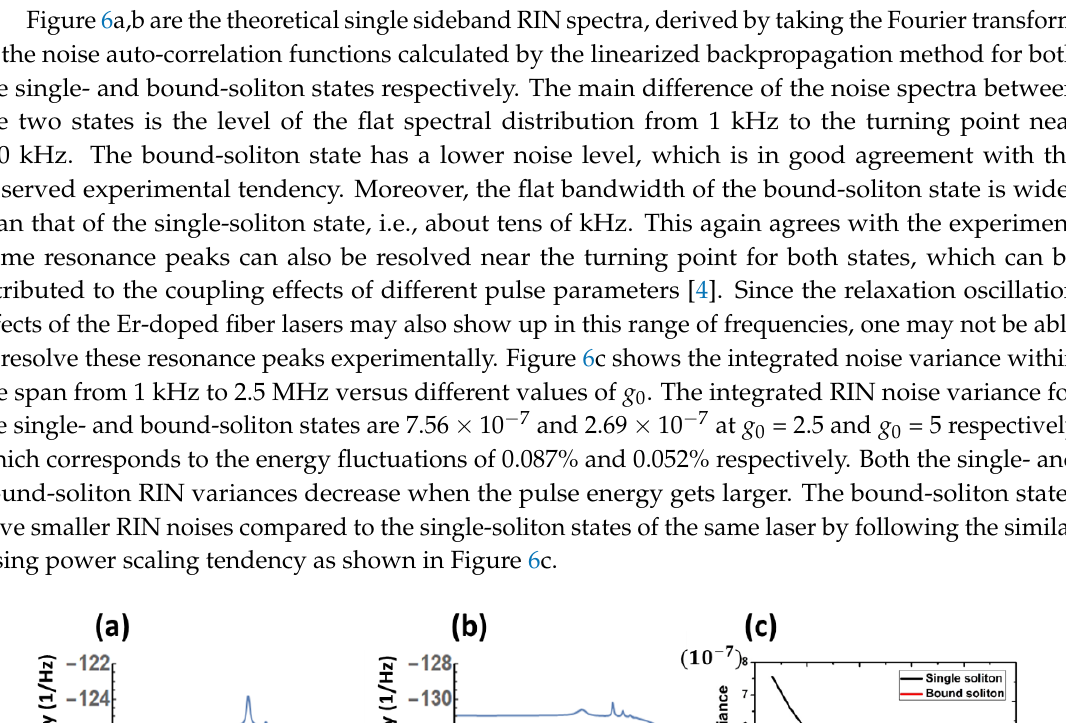
= 2.5 and ( b ) bound-soliton state 𝑔𝑔 0